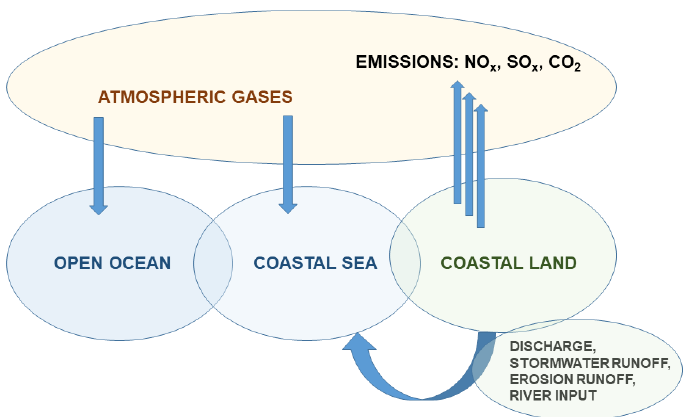
Figure 3. Schematic diagram of the sources of ocean acidification. Coastal land is exposed to a vari- ety of acidic sources, adding to the coastal sea, and varying across time and space, as adapted from Clements and Chopin